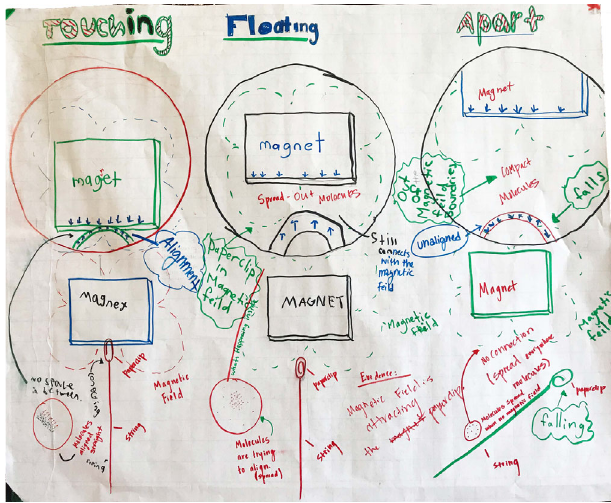
1. One group ’ s final model that shows something happen- ing inside the magnet and paperclip with noticeable ambiguity. The system is shown at three points in time, when the paperclip is touching the magnet (left), inside the magnetic field but not touching (middle), and far apart (right). In all instances there are small entities inside the magnet and paperclip represented by arrows that are pointed towards each other and dots with various distributions. The magnetic field is drawn around the magnet in the shape of a four-petaled flower. Figure 1c from “ Modeling Magnetism With the Floating Paper Clip, ” by S. Braden,